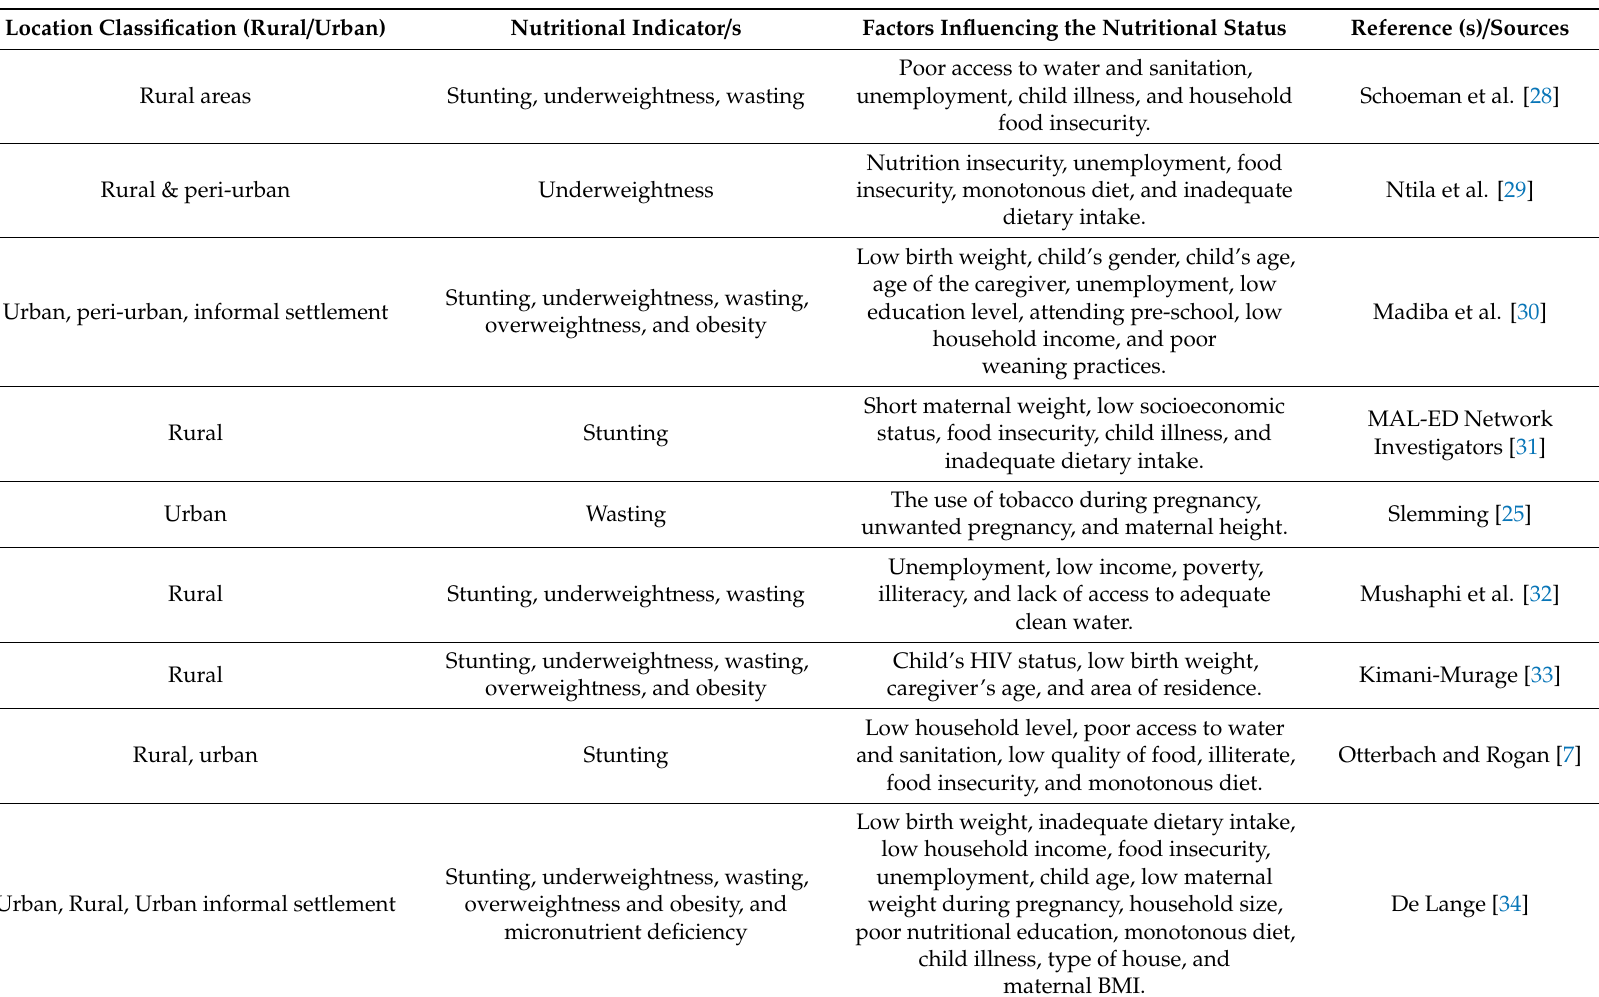
Table 3. A summary of the factors that influenced the nutritional status of children under five years of age in South Africa using data from the selected